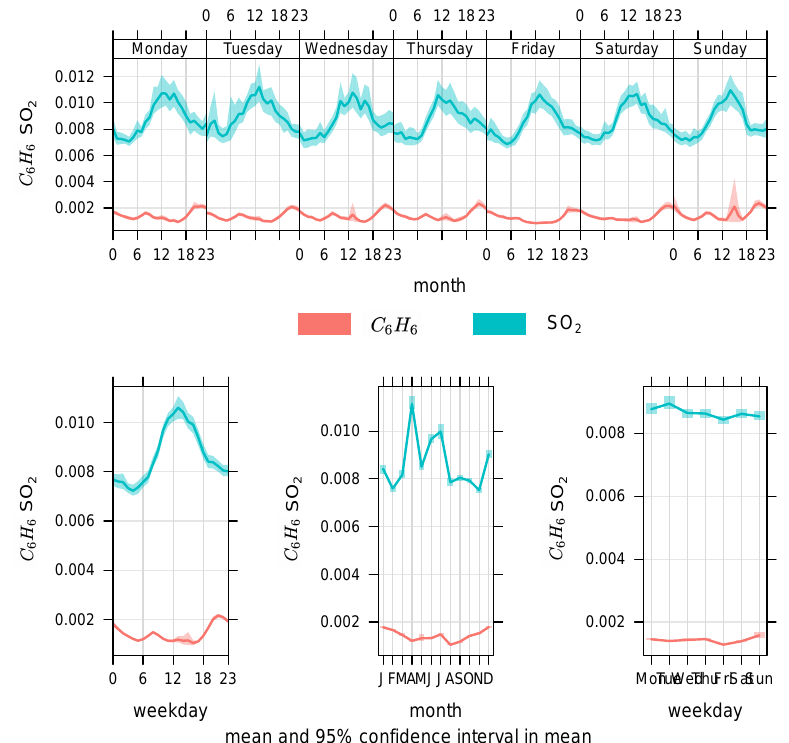
Figure 6. Temporal variation of the Studied Pollutants according to the station site from 2012 to 2017 for C 6 H 6 and SO 2 —EPA